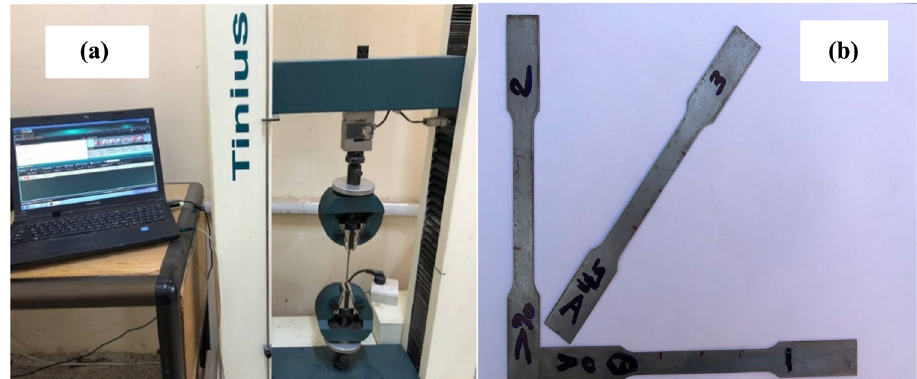
Figure 6: ( a ) Tensile test machine. ( b ) Tensile specimens.